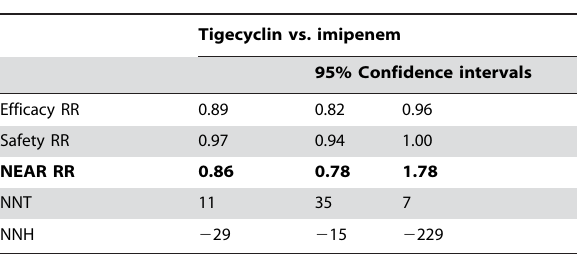
Table 8. Results of classical RR, NNT and NNH variables together with the new NEAR RR for a CRT comparing tigecycline versus imipenem/cilastatin in patients with complicated intra-abdominal infections [11].